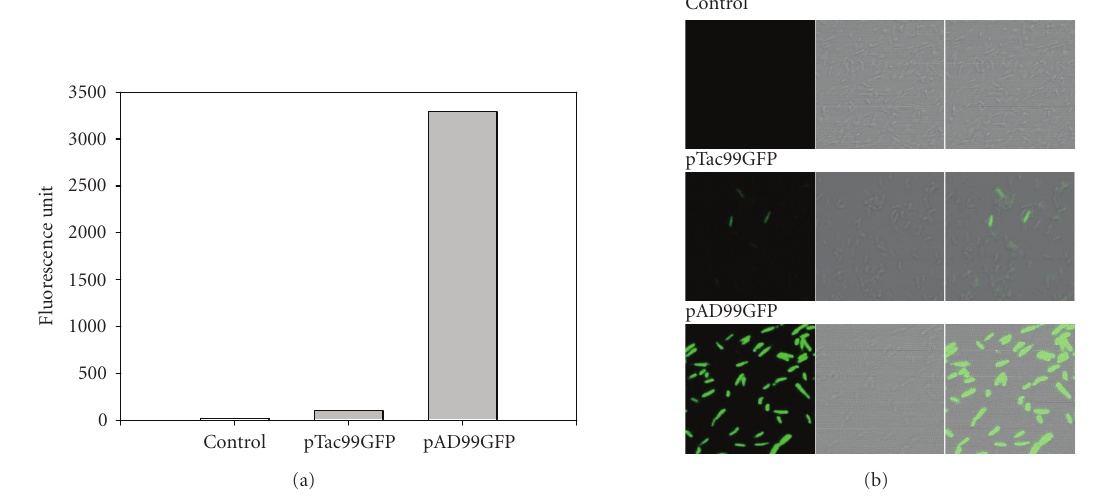
Figure 6: The fluorescence intensities (a) and confocal microscopic images (b) of E. coli W3110 cells by induction with IPTG (middle panels) or oleic acid (bottom panels). As a control, the E. coli strain without plasmid is also shown (top panels). Shown in (b) are immunofluores- cence micrographs (left panels), di ff erential interference micrographs (middle panels), and merged images (right panels) of wild-type E. coli W3110 and its recombinant cells harboring pTac99GFP and